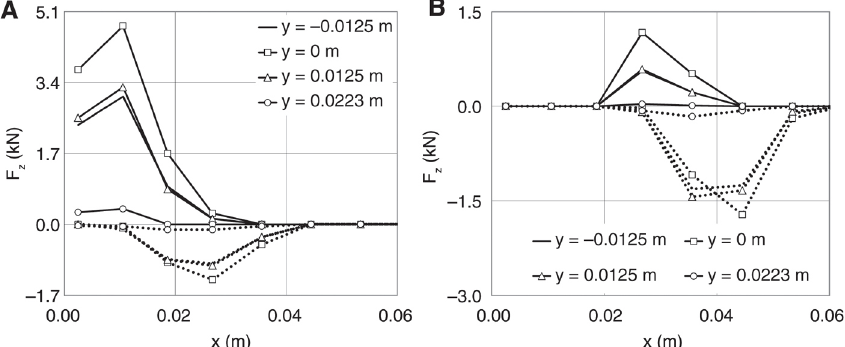
Figure 13: The variation of F groove ’ s web and along the respective lines on the upper edge of the groove ’ s